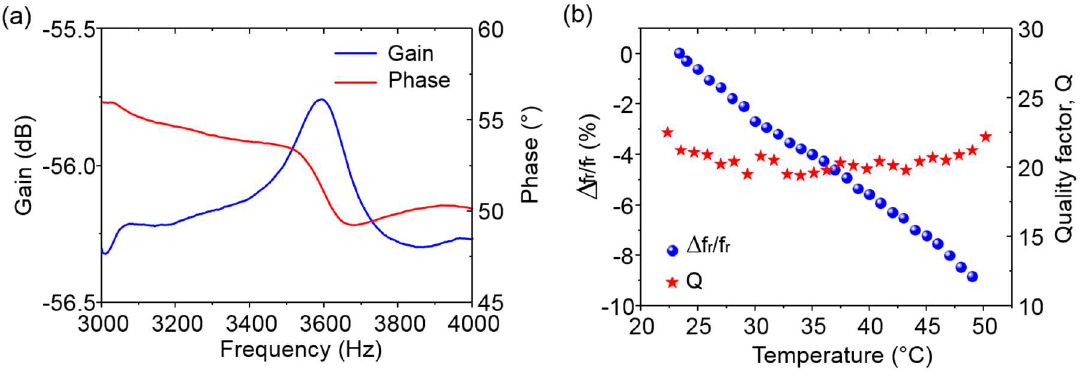
Figure 2. Electrical measurements of ( a ) Amplitude and phase of the resonant frequency of the first out-of-plane flexural mode measured by piezoresistive detection; and ( b ) Relative shift of resonant frequency and quality factor as a function of temperature.